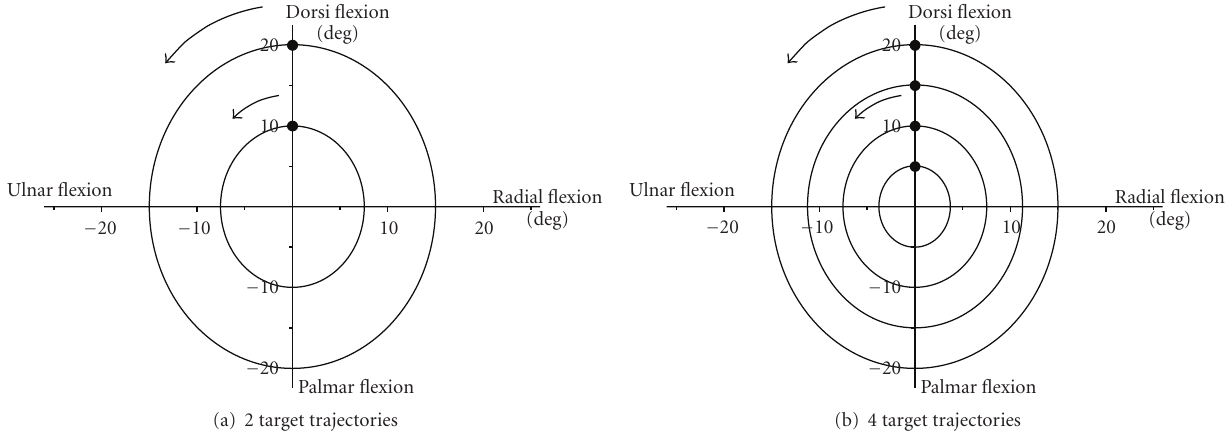
Figure 3: Target joint angle trajectories to obtain training data for ISM learning. Cycle period was 30s for all trajectories.